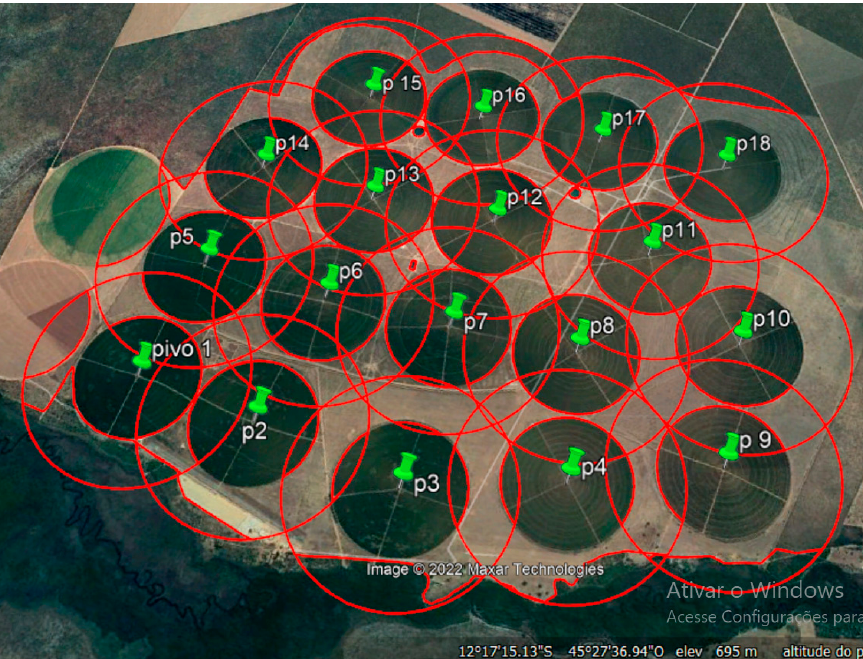
Figure 2. Satellite images of the Milan Farm from Google Earth Pro. A radius of 1.000 m from the center of the pivot. The letter (P) and numbers indicate the pivot in the farm.